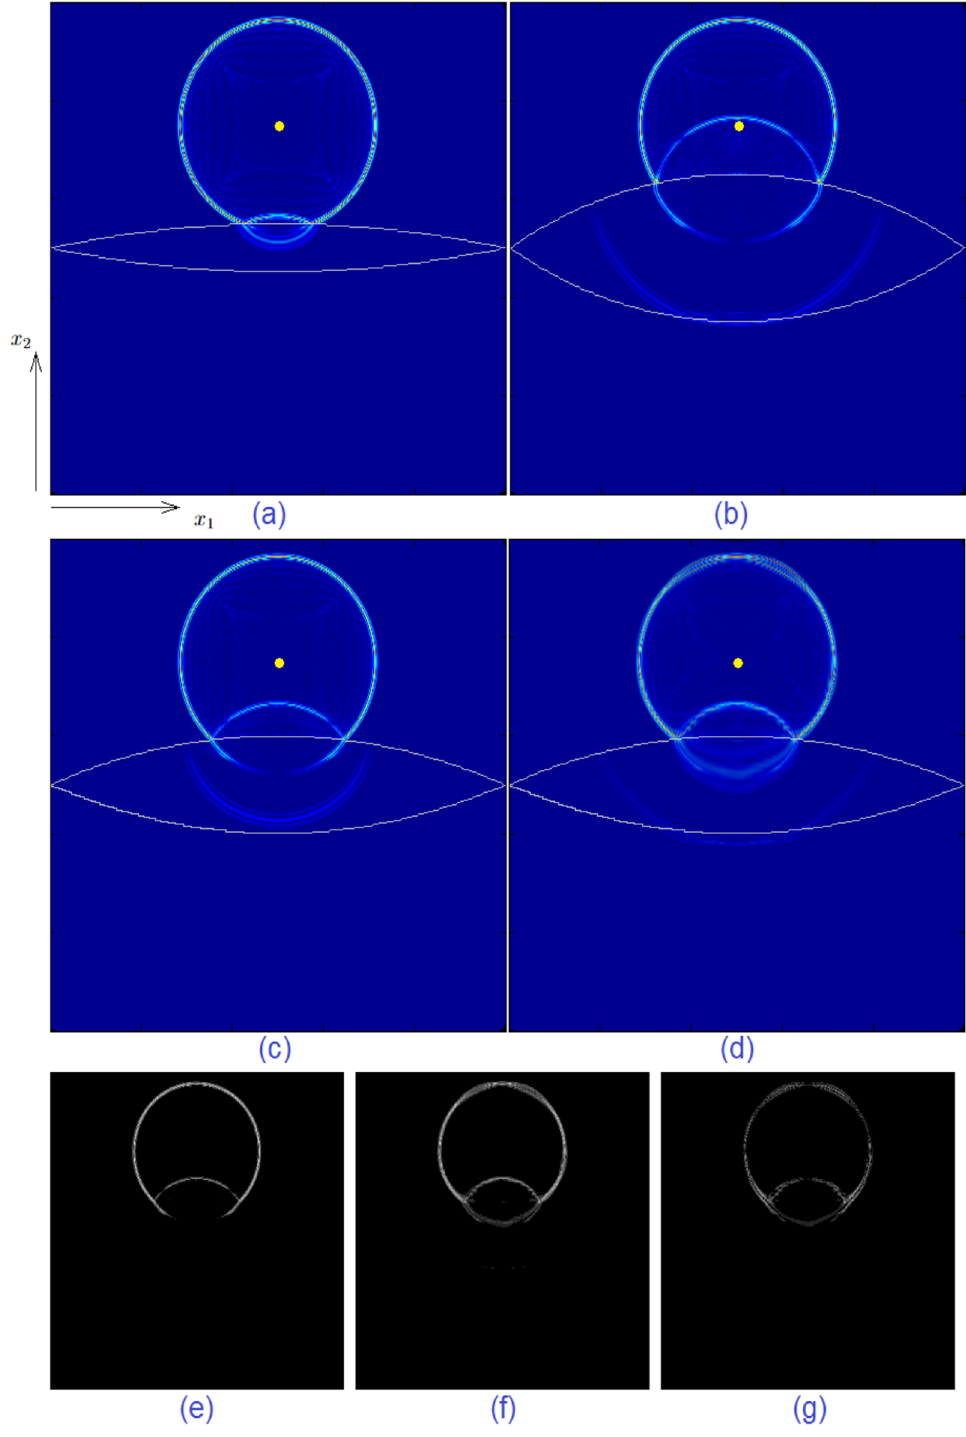
Fig. 4. Snapshot time t =140 m s for the radiation pattern of a point force (directed along x 2 ) generating a Ricker pulse with central frequency 250kHz and spectral bandwidth 10kHz, which is located at 12.5 cm from the top and 25 cm from the left and the right edge of a fi eld of 50cm by 50cm, applied to three cases. (a) Applied to the “ Lens 1 ” , (b) applied to the “ Lens 3 ” , (c) applied to the “ Lens 2 ” ; morphing result (d) between (a) and (b); (e) is (c) transformed in a grayscale image; (f) is (d) transformed in a grayscale image and (g) is the absolute value of the difference between (e) and